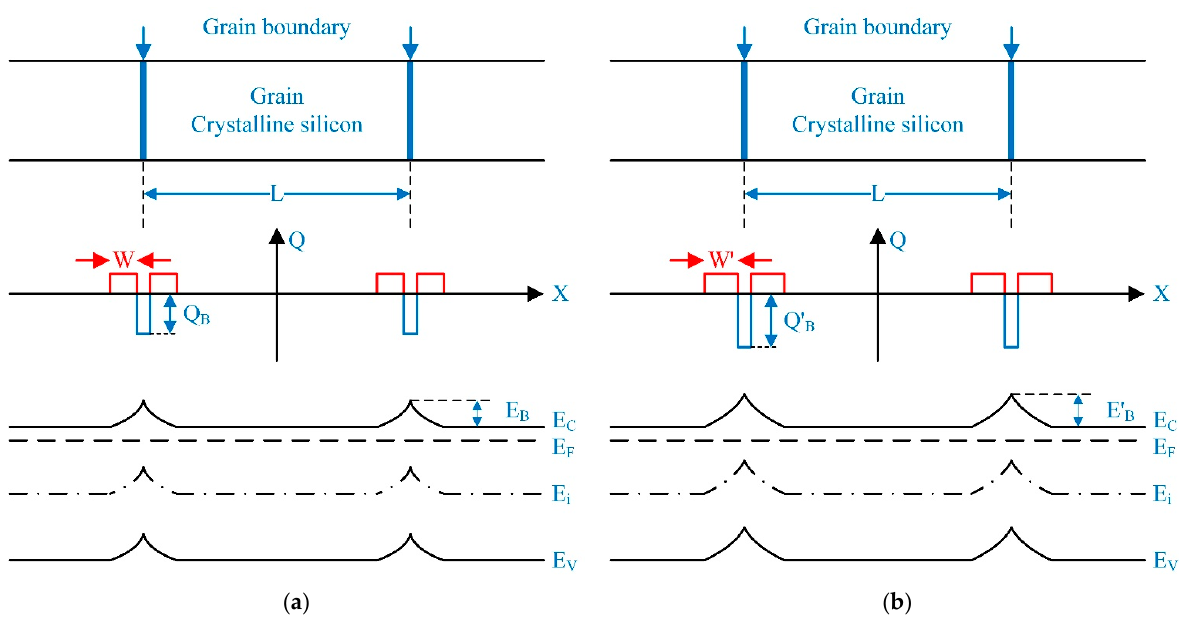
Figure 8. The electron radiation effect on potential barrier of grain boundary in the energy band of polycrystalline silicon: ( a ) before grain boundary evolution; ( b ) after grain boundary evolution.